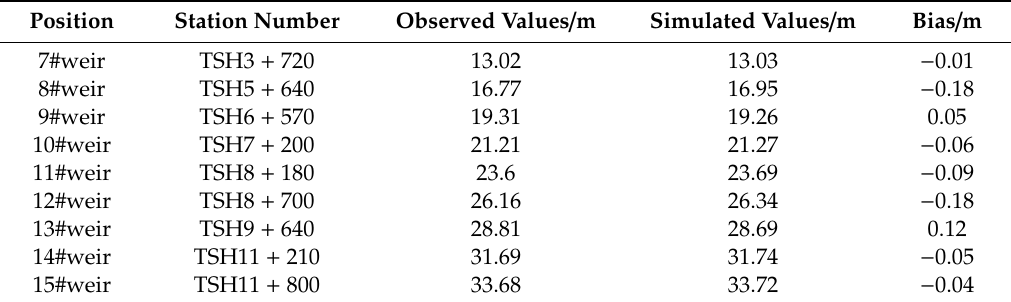
Table 2. Comparison of simulated and observed water